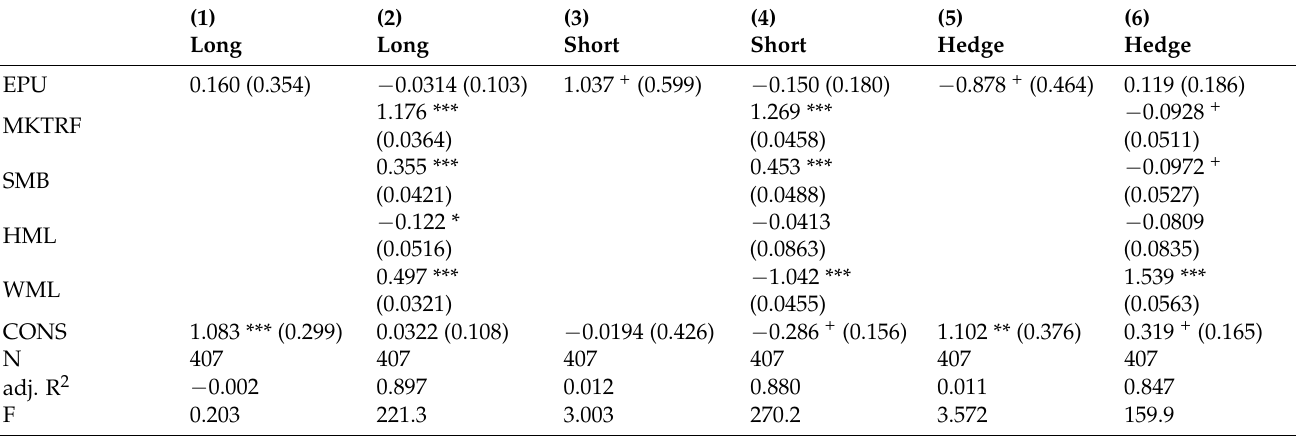
Table 8. Time series regression and